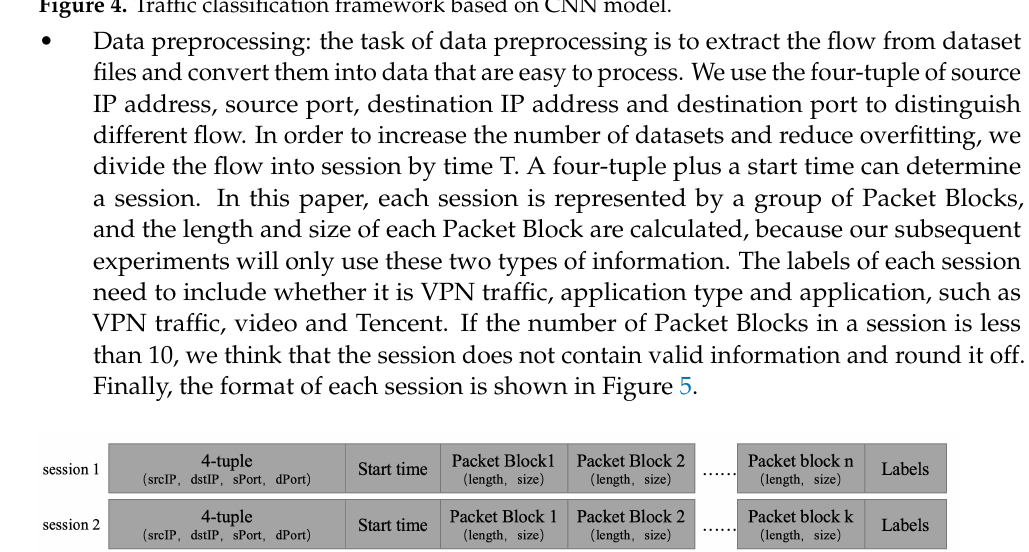
Figure 4. Traffic classification framework based on CNN model.